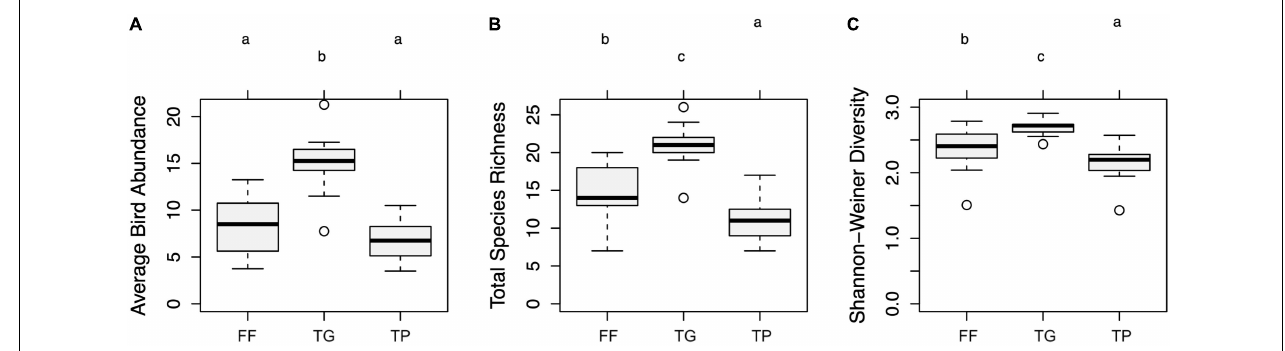
FIGURE 2 | (A) Bird abundance, species richness per point count, and diversity by land use: FF = forest fragment, TG = tree garden, TP = tea. Letters indicate differences in Tukey post hoc tests ( p < 0.05) and Kruskal-Wallis tests with Bonferroni correction a > b > c. (B) Bird abundance by habitat association and land use. (C) Endemic bird abundance and species richness and abundance of birds of conservation concern by land use.